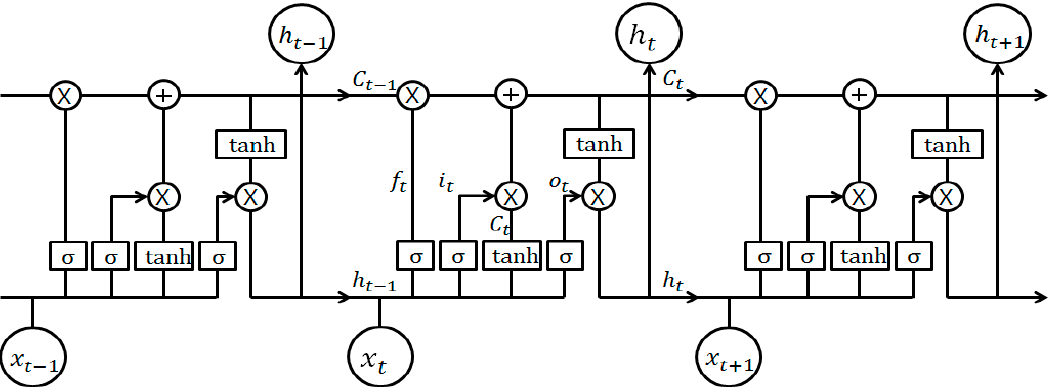
Figure 3. Basic structure of LSTM .